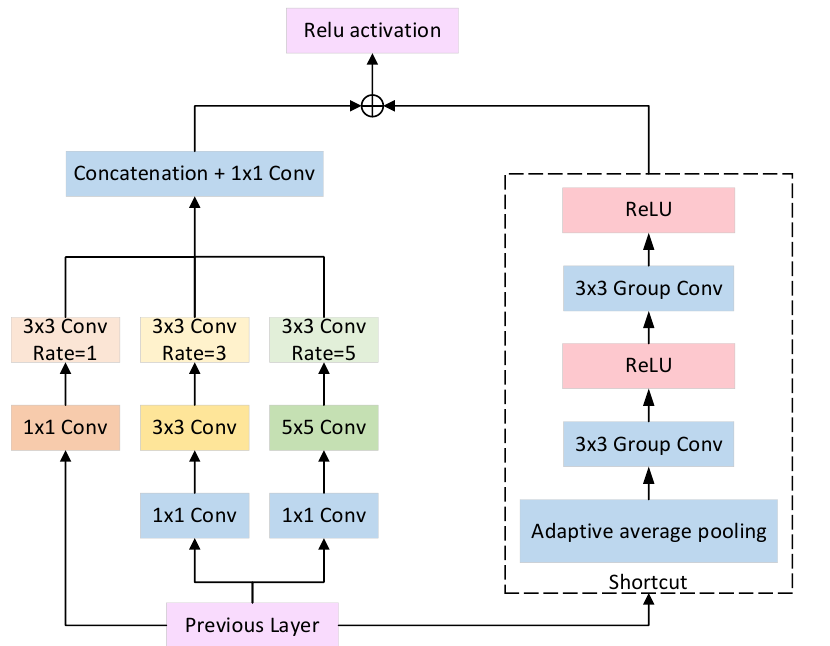
Figure 4. CRF receptive field module .